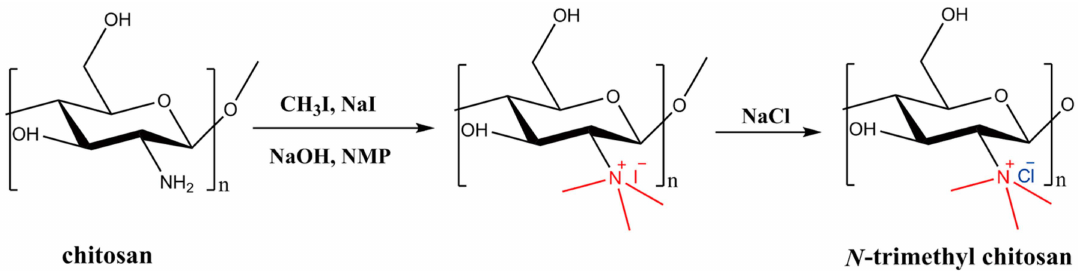
Figure 1. The synthesis of N -trimethyl chitosan (TMC).